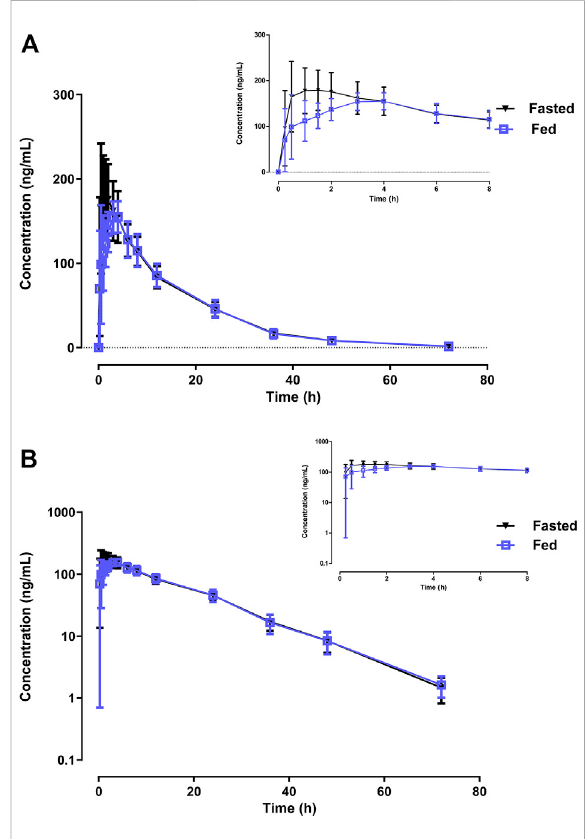
FIGURE 2 The linear (A) and semi-logarithmic (B) mean plasma concentrations-time pro fi les after a single dose of 10 mg WXFL10203614 under fed and fasted conditions. The data are expressed as mean ± standard